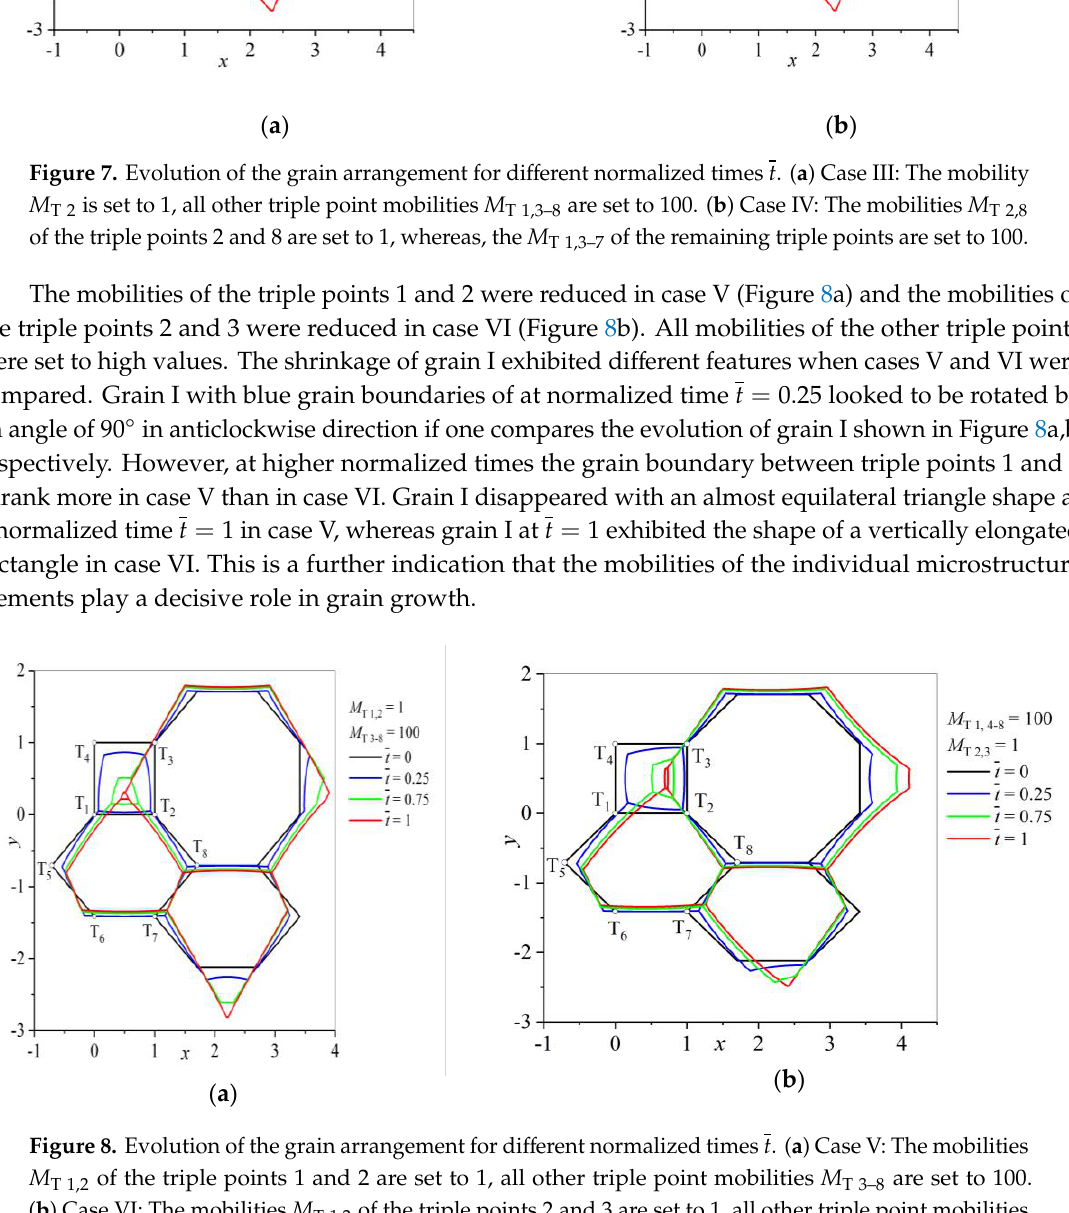
( b ) Case VI: The mobilities M T 1,2 of the triple points 2 and 3 are set to 1, all other triple point mobilities M of the triple points 2 and 3 are set to 1, all other triple set to 100. (b) Case VI: The mobilities 2 T 1, M T 1,4–8 are set to